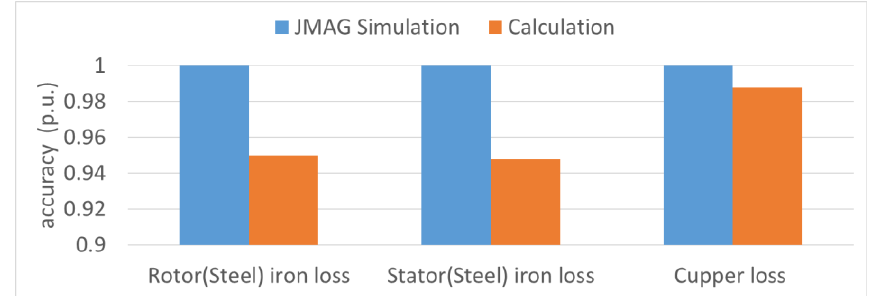
Figure 11. Comparison of estimated power losses and calculated power losses.